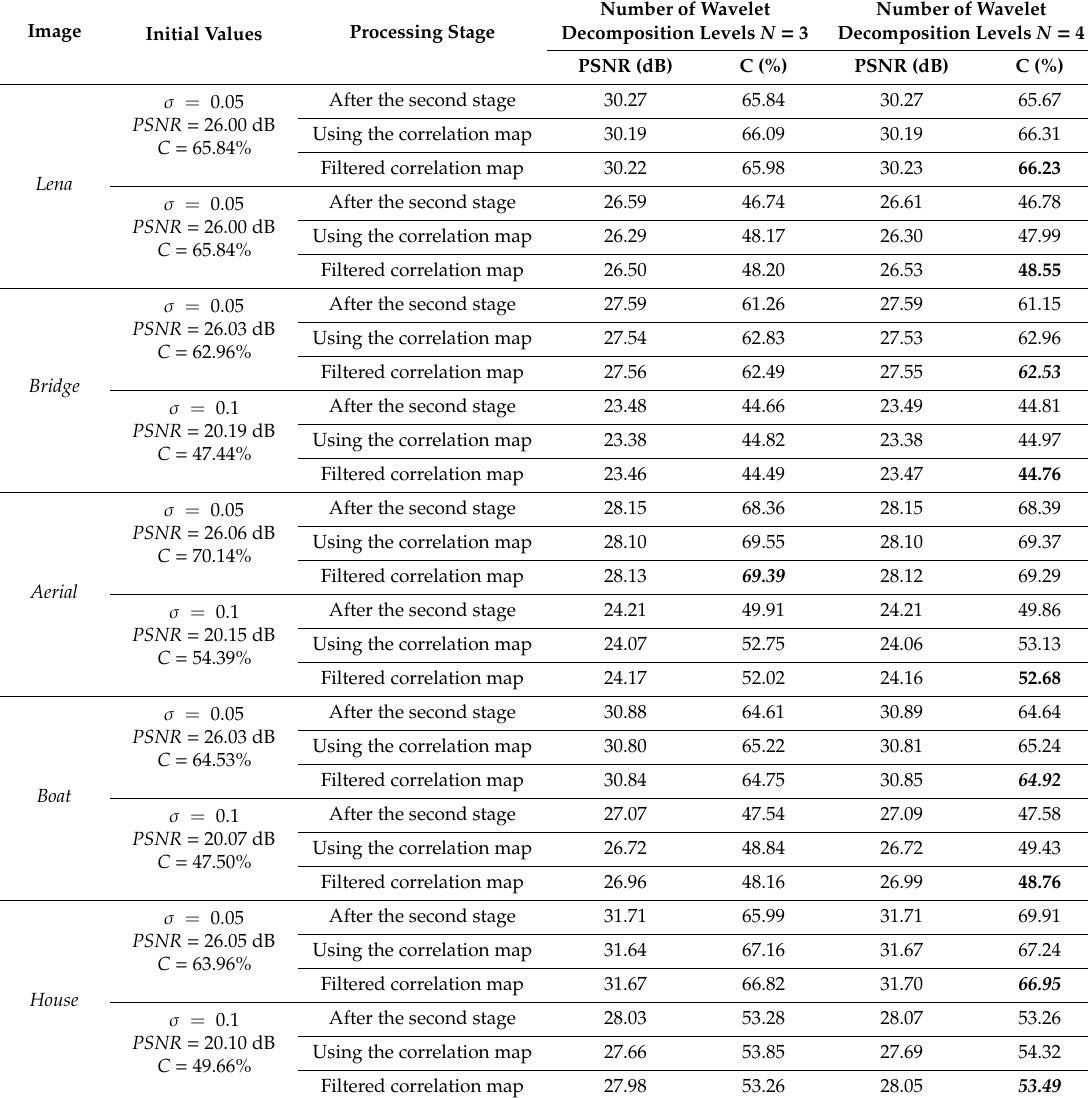
Table 4. Dependence of the results obtained by applying the filtering algorithm proposed, depending on the number of wavelet decomposition levels. The test images were 256 × 256 pixels and were degraded with white Gaussian additive noise. The threshold values used to obtain the contour map from the hierarchical correlation map are t c = 0.1 for σ = 0.05 and t c = 0.15 for σ =